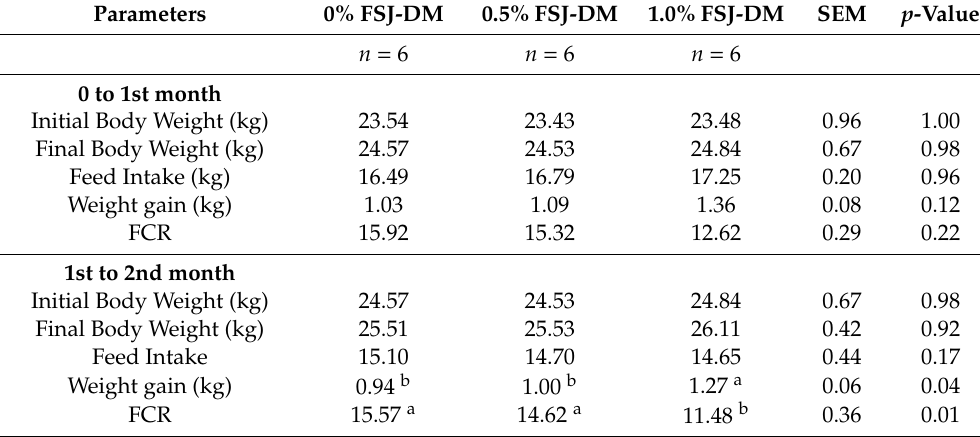
Table 4. Growth performance of KNBG fed fermented S. japonica and D. morbifera (FSJ-DM).